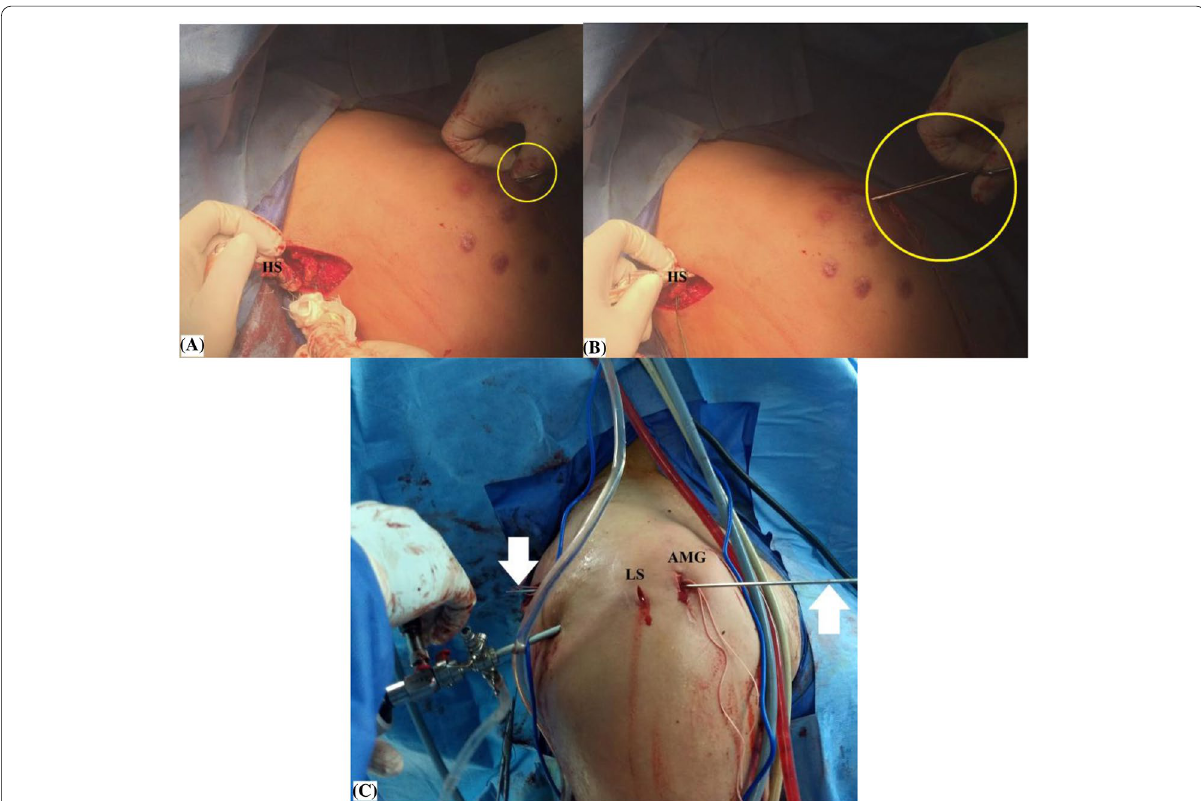
Fig. 8 A, B, C demonstrate sub/trapezius sub‑acromial passage of the hamstring sheet in currently reported technique of middle trapezius − − tendon transfer in the right shoulder. A, a long straight artery clamp (marked in yellow circle) passed through McKenzie approach under the acromion to the scapular wound to establish a sub‑trapezius/sub‑acromial corridor; B, sub‑trapezius/sub‑acromial shuttling of the hamstring sheet aided by the passed long straight artery clamp (marked in yellow circle); or alternatively by; C, an anterior cruciate ligament guide pen (marked by white arrows); the latter is valid for both open and arthroscopic‑assisted modalities of currently reported technique; AMG, anterior mid‑glenoid portal; HS, Hamstring sheet; LS, lateral sub‑acromial portal